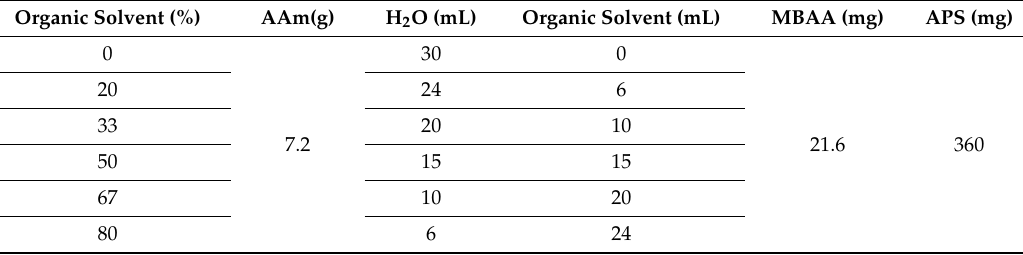
Table 1. PAAm organohydrogels with di ff erent solvent